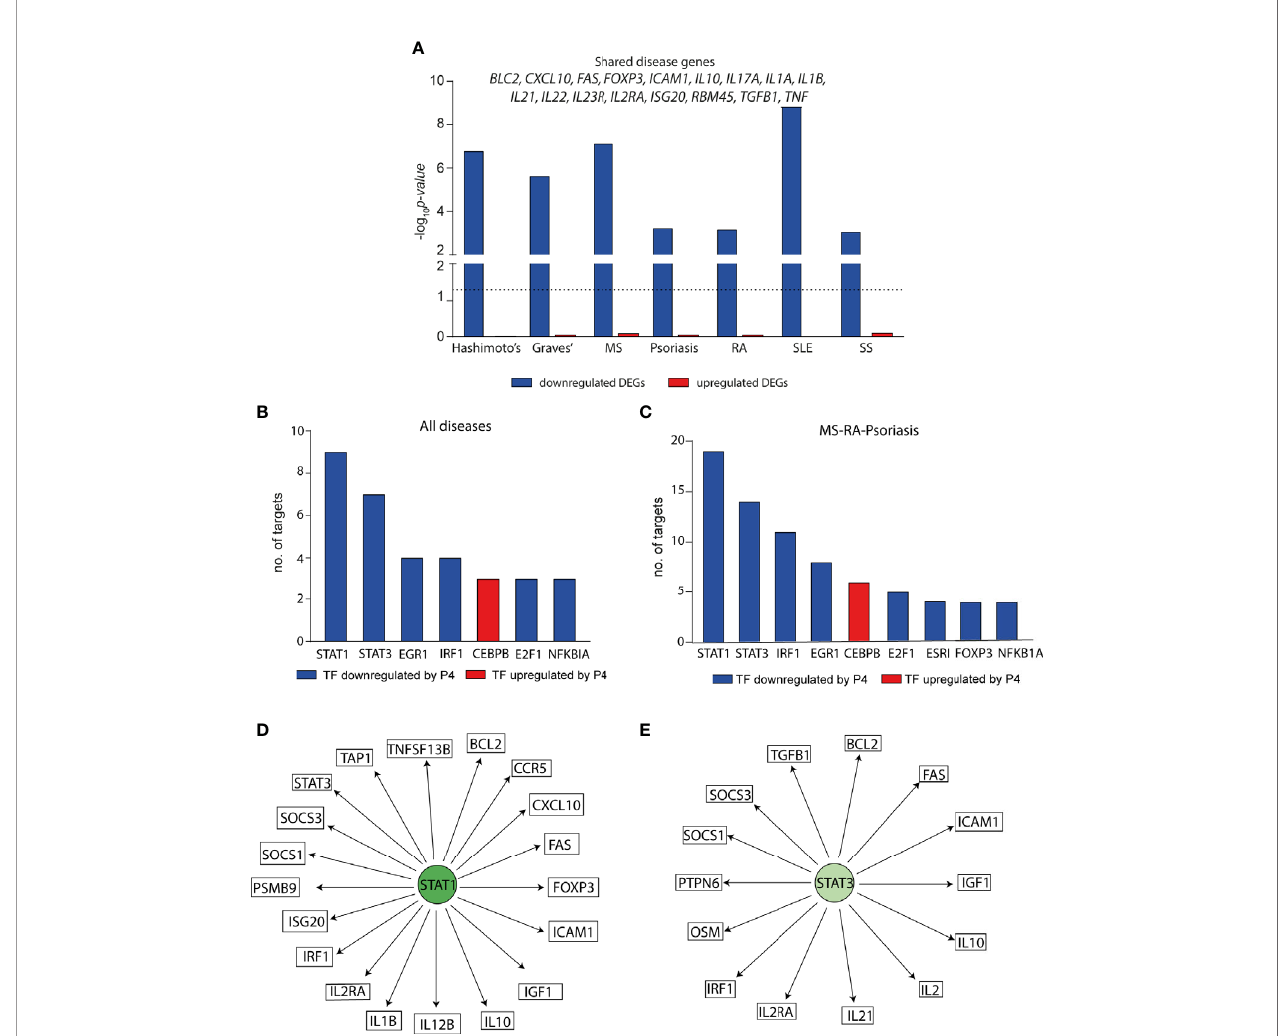
FIGURE 4 | Progesterone downregulates disease-associated genes for several autoimmune diseases particularly through STAT1 and STAT3. The effect of P4 on disease-associated genes and upstream transcription factors was interrogated using known disease genes (derived from DisGeNET) and TF-target interactions were based on TRRUST and DoRothEA. (A) Enrichment of disease-associated genes for seven autoimmune diseases among the differentially expressed genes by P4. Downregulated DEGs = blue bars, upregulated DEGs = red bars. DEGs were de fi ned comparing cells activated in the presence of P4 as compared to activation alone and represent the total number of uniquely expressed genes at 6 and 24 hrs combined. Dotted line shows p=0.05. The genes that are common between all seven diseases among the differentially downregulated genes by P4 are depicted above the bars. Enrichment p values were calculated by Fisher ’ s exact test. The TFs with the highest number of interacting genes among the disease-associated differentially downregulated genes for (B) shared genes between the seven different diseases (out of 36 TFs in total) and (C) common genes between MS, RA and psoriasis (out of 57 TFs in total). (D, E) Schematic representation of STAT1 and STAT3 and their interacting genes. STAT1 and STAT3 are signi fi cantly downregulated by P4 as are their targets depicted in the fi gure. DEGs, differentially expressed genes; MS; multiple sclerosis; P4, progesterone; RA, rheumatoid arthritis; TF, transcription